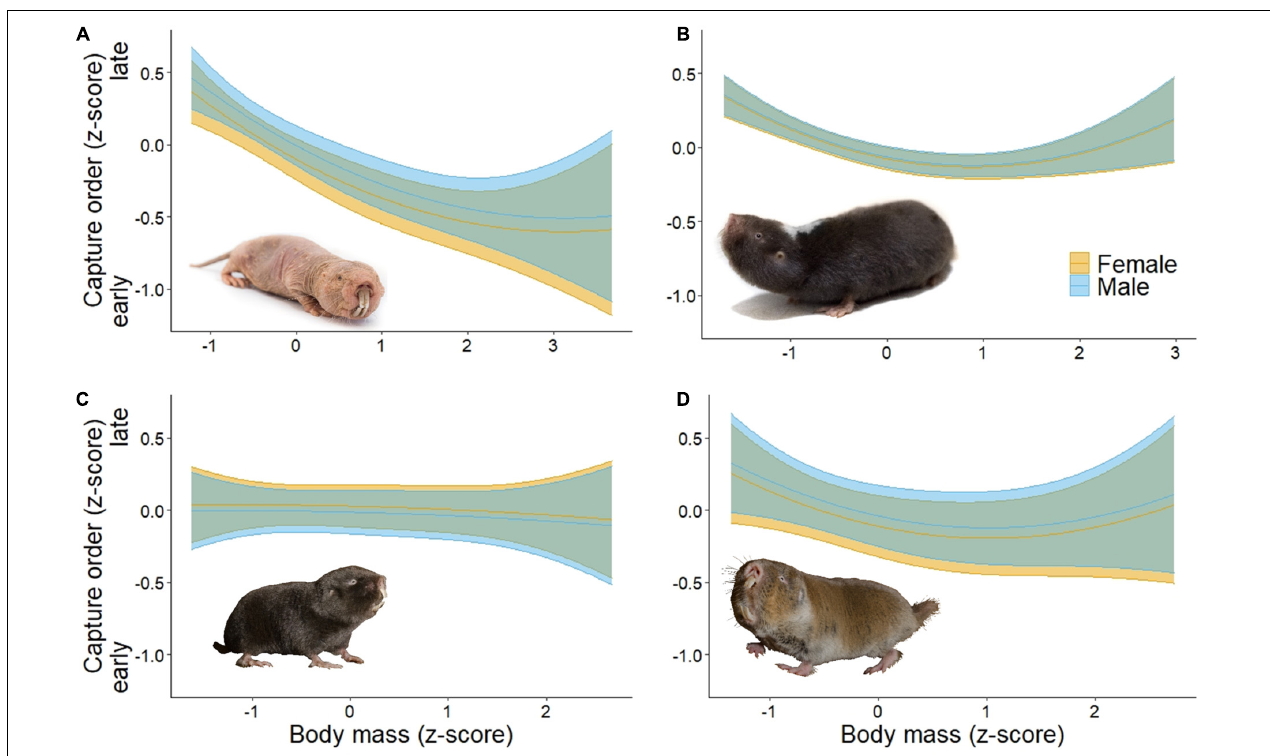
FIGURE 2 | The predicted effects of body mass on capture order of male and female non-breeding group members in (A) Naked mole-rats, (B) Damaraland mole-rats, (C) Natal mole-rats, and (D) Mahali mole-rats. The shaded areas represent 95% confidence intervals and the test statistics can be found in Table 1 . Note that the effects displayed in panels (C,D) do not represent statistical significant effects. Photographs by Kyle T. Finn and Yannick